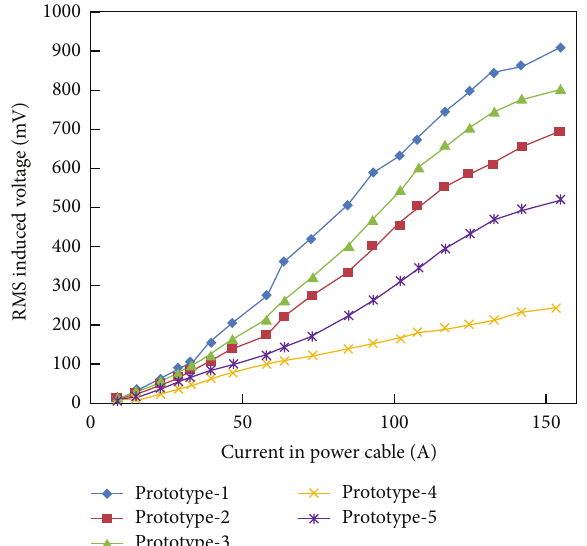
Figure 16: Induced load voltage in inductive energy harvesters as a function of cable current.